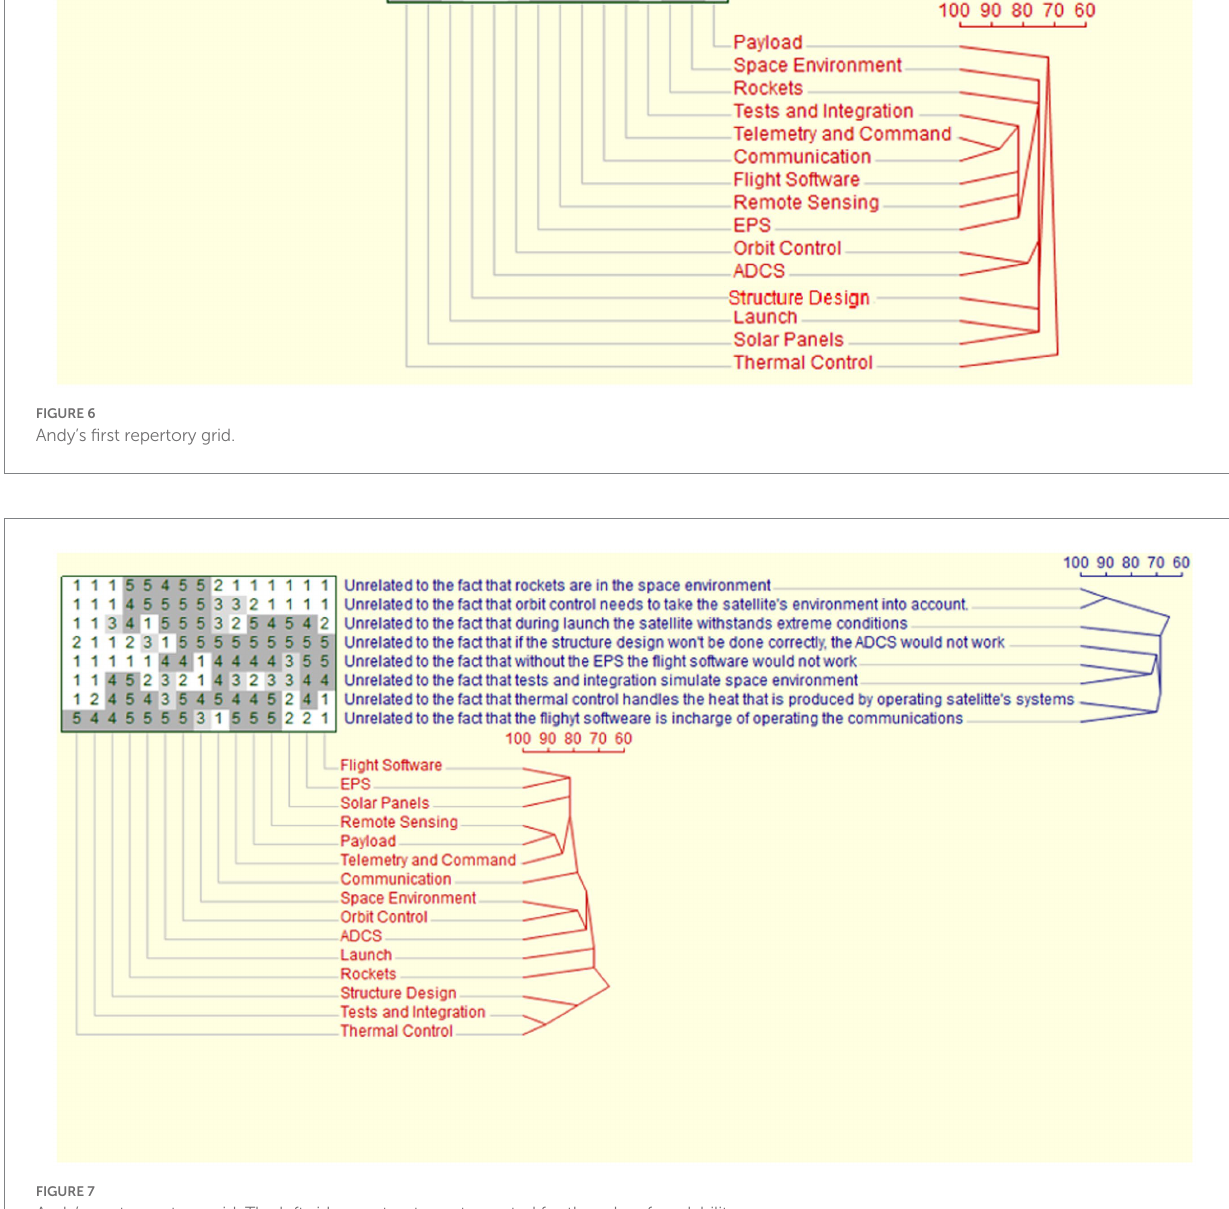
FIGURE 7 Andy’s post repertory grid. The left side constructs are truncated for the sake of